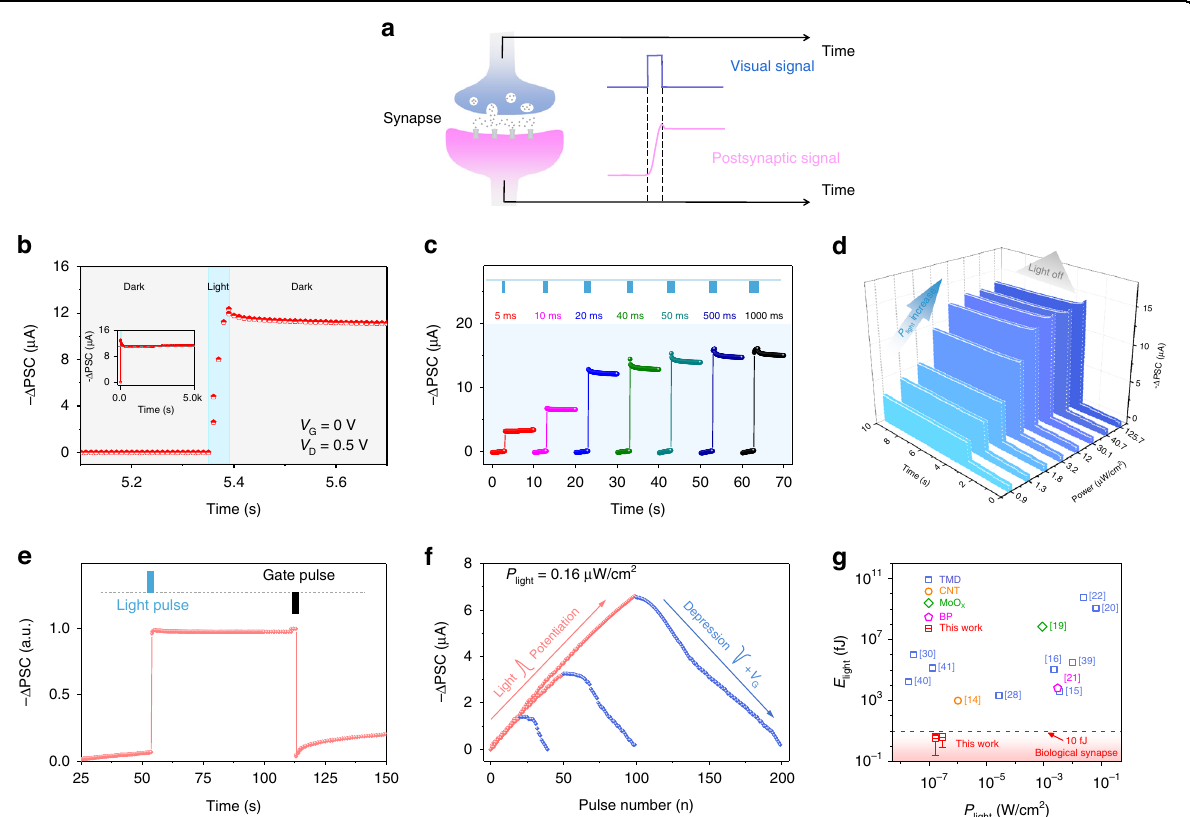
Fig. 3 Typical synaptic behavior of arti fi cial synapse. a Schematic diagram of optical signal for photonic arti fi cial synapse. b Photo-activated postsynaptic current ( − Δ PSC) of the arti fi cial synapse at P light = 11.97 μ W cm − 2 and V G = 0 V with light pulse width at 50 ms. Inset: − Δ PSC with longer monitoring time, it remains well after 5000 s. c − Δ PSCs under different light pulse width at a fi xed P light of 11.97 μ W cm − 2 , V D = 0.5 V, and V G = 0 V. d − Δ PSCs under different P light at a fi xed light pulse width of 50 ms ( V D = 0.5 V, V G = 0 V). e The programming and erasing process of persistent PSC by light pulse and positive V G pulse. f LTP/LTD characteristics trained by 20/50/100 consecutive potentiation pulses and 20/50/100 depression pulses. Potentiation process: light pulses; illumination time, 5 ms; light power, 0.16 μ W cm − 2 . Depression process: electrical spikes; pulse time, 5 ms; voltage amplitude, uniformly increasing gate voltage from 0 to 4 V. g The summary of energy consumption in single photonic programming process ( E light ) of arti fi cial photonic synapses with different